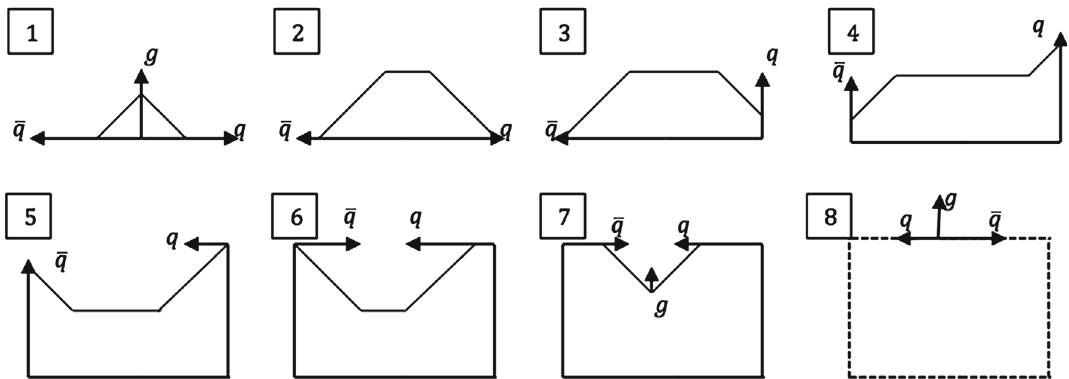
Fig. 6 Time evolution of the qg ¯ q system formed by massless partons in a frame where the gluon moves in the + x direction, while the q and ¯ q move in opposite directions along the z axis